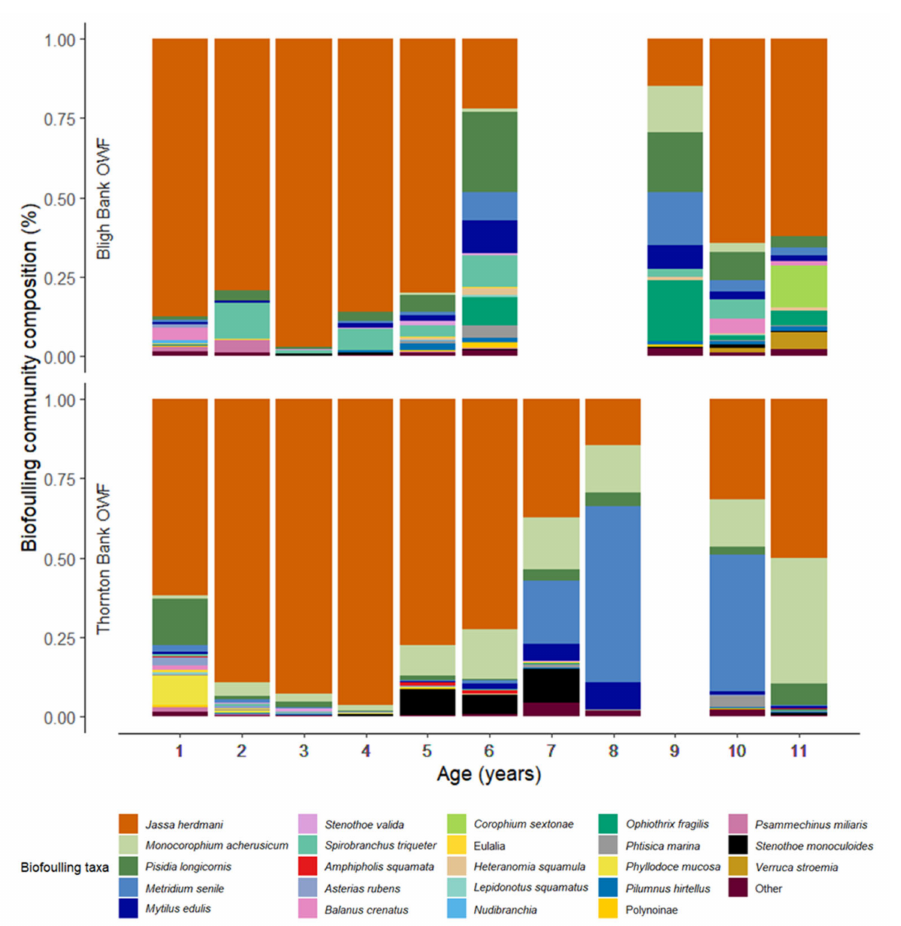
Figure 6. Temporal changes in relative abundances for biofouling taxa in the two offshore wind